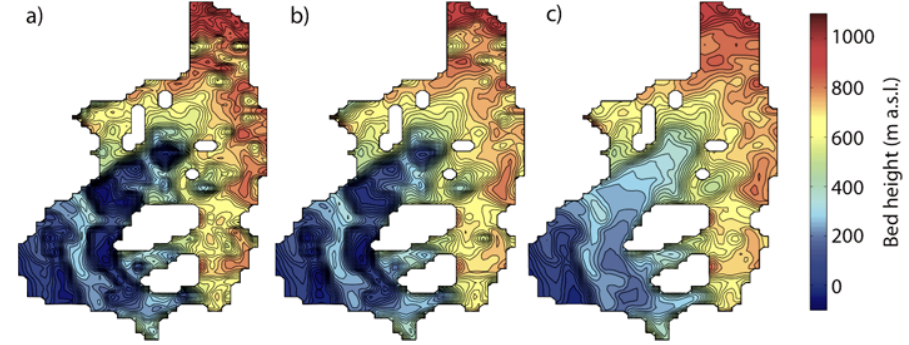
Fig. 14. Bed heights computed using the perfect-plasticity assumption using minimum slope thresholds of 0.015 (a) , 0.02 (b) and 0.04 (c) .